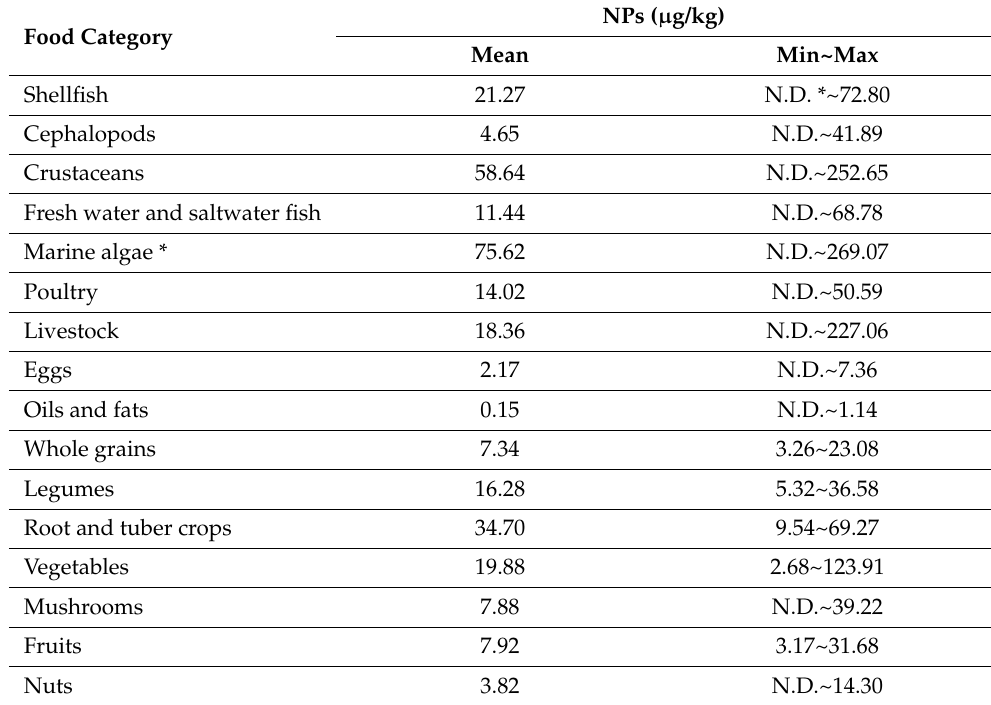
Table 4. Concentration of NPs in food